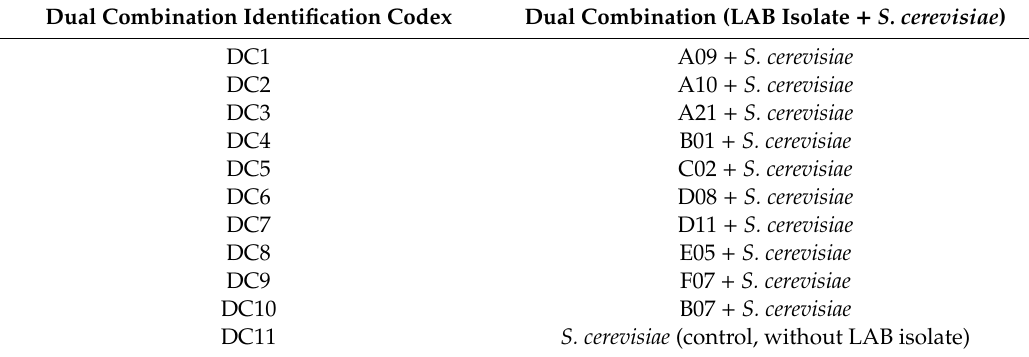
Table 3. Dual combinations of the Saccharomyces cerevisiae strain and lactic acid bacteria (LAB) isolates for the sourdough preparation.